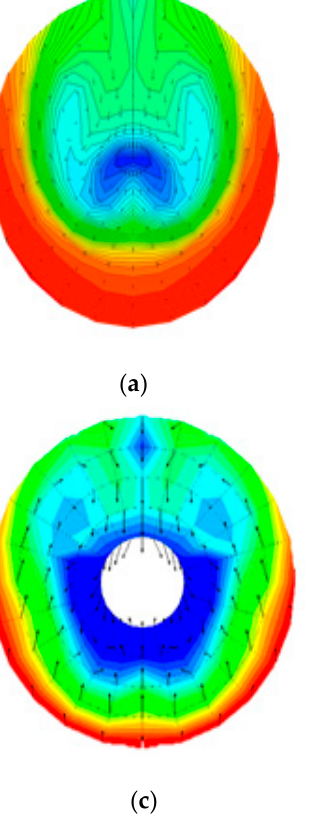
Table 5. Comparison of self-propulsion analysis results between EFD and CFD.